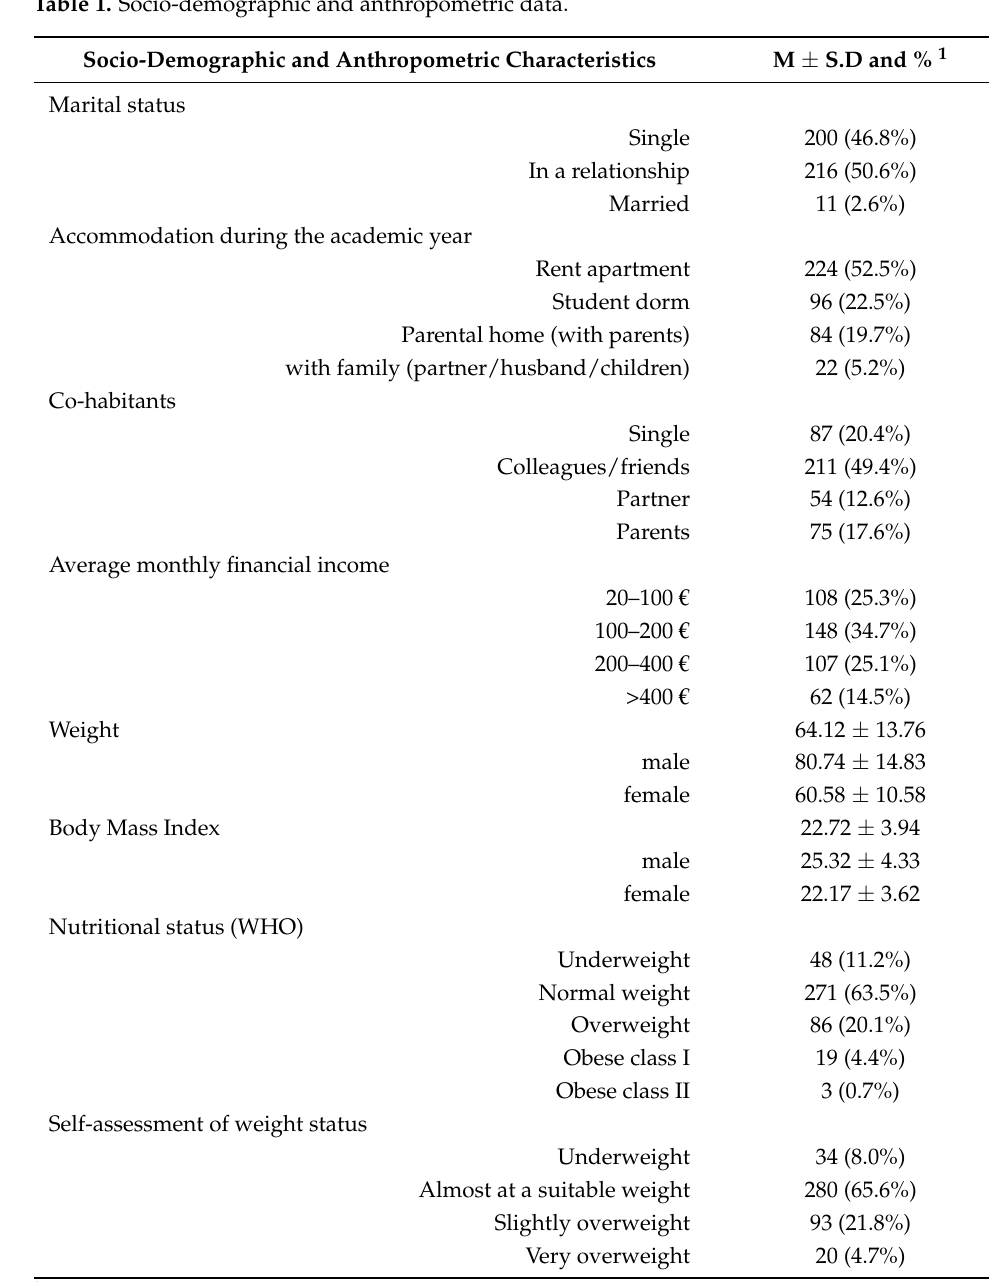
Table 1. Socio-demographic and anthropometric